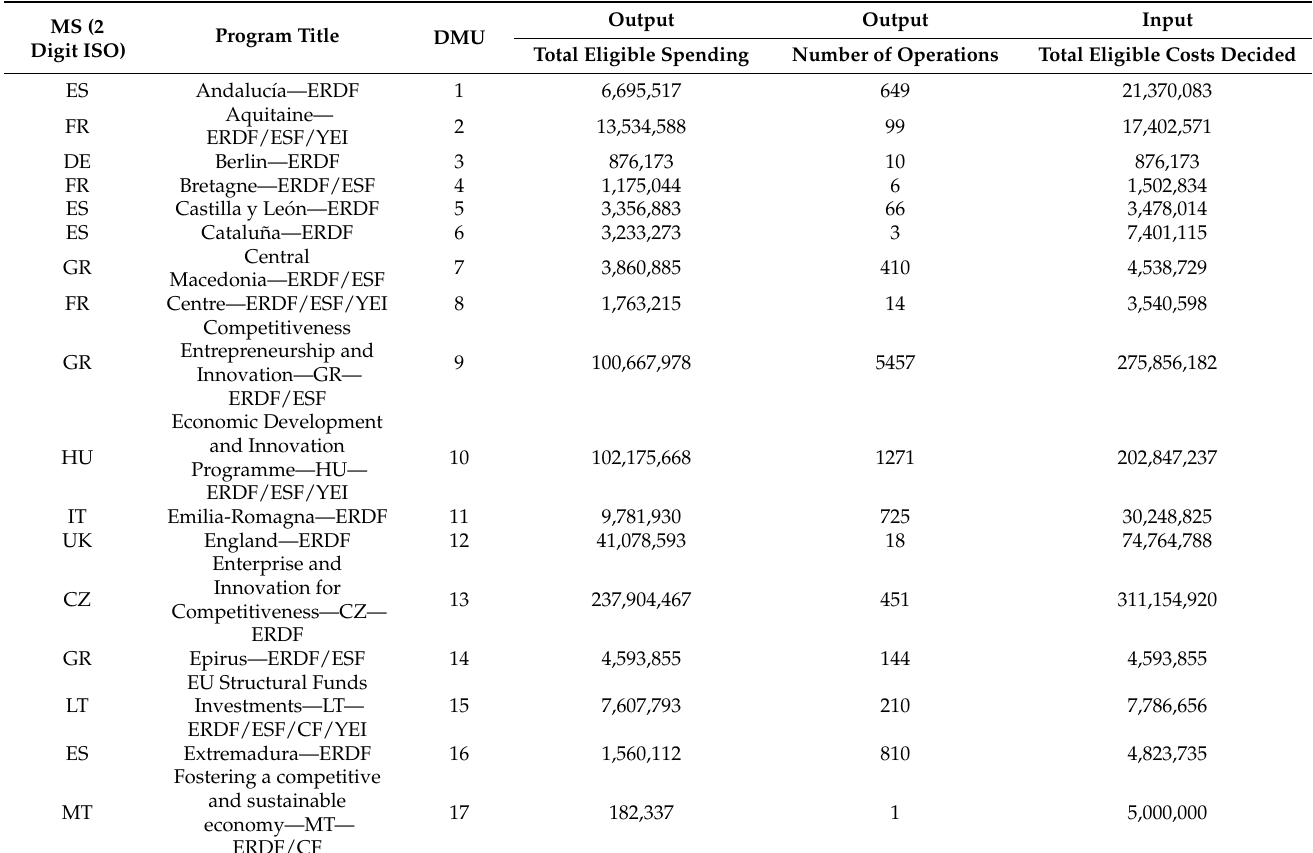
Table A2. Data on the inputs and